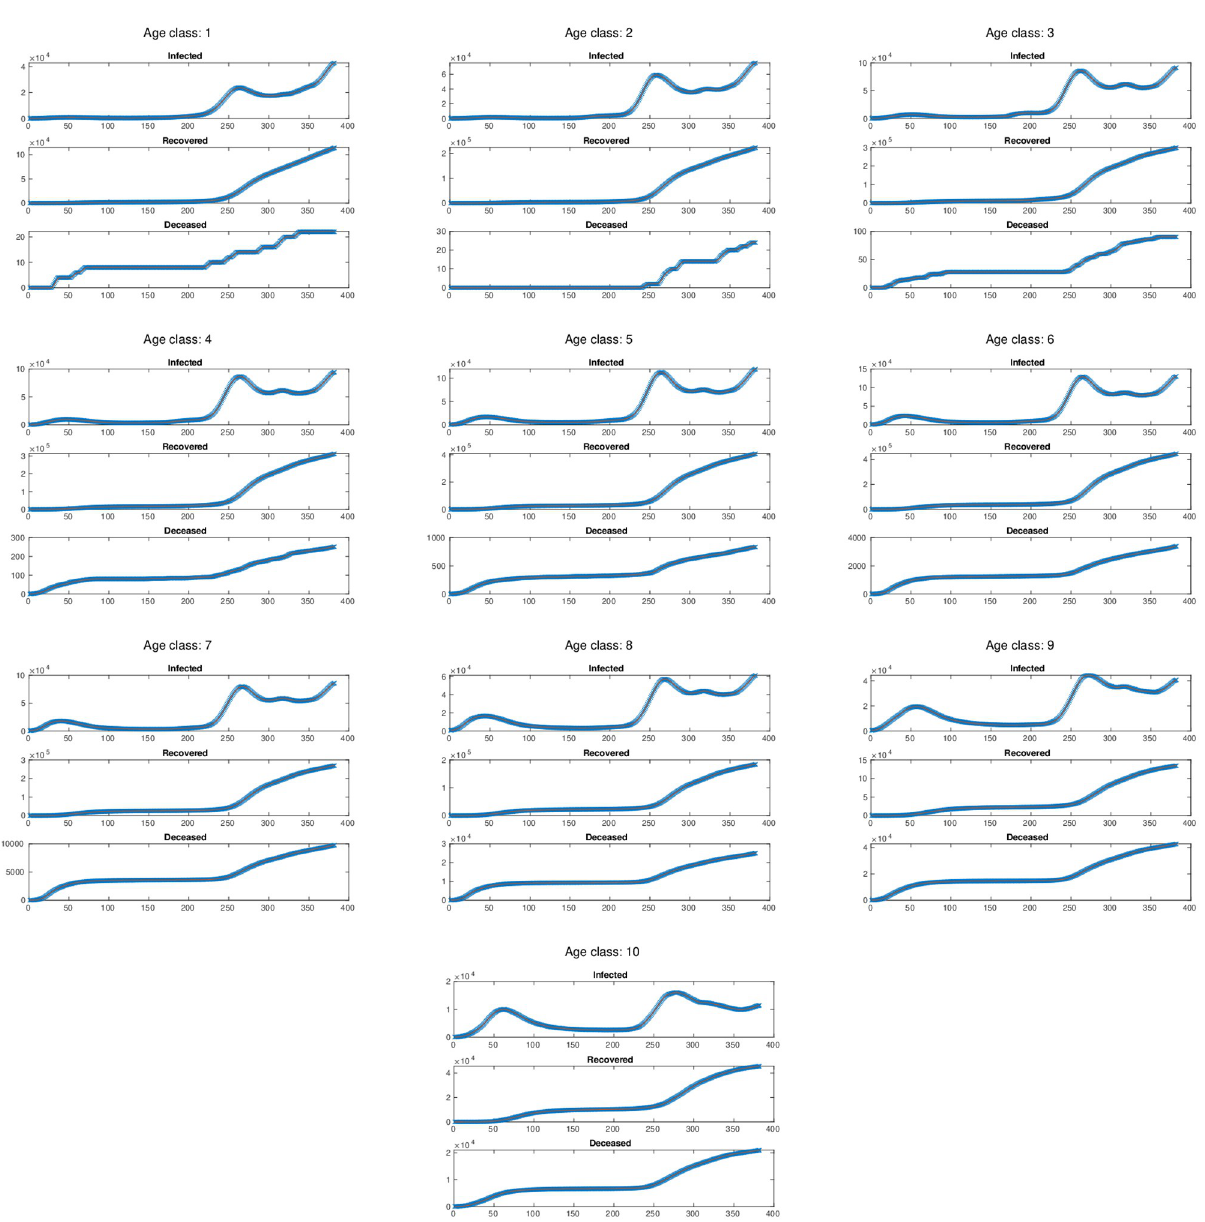
Fig 3. Per-class multi-simulation prediction using the optimal parameters � y � . The red curve describes the multi-simulation prediction, and the blue crosses represent the actual data used for model training.